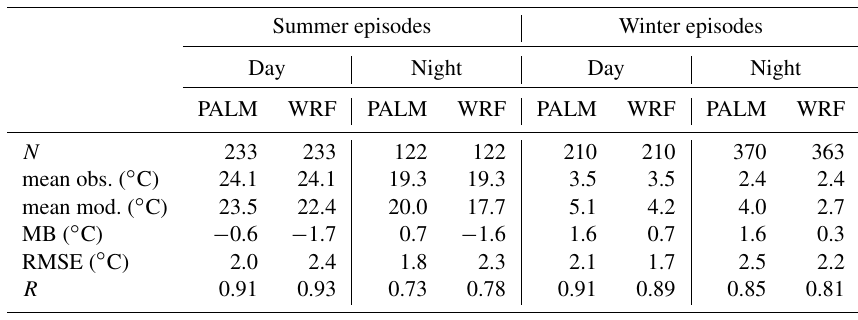
Table 3. Statistical metrics of modelled 1h averaged air temperature within different street canyons. The statistics are evaluated over all locations and episodes considered, and they are partitioned into summer and winter as well as day- and night-time. The statistical metrics for the modelled 2m air temperature in WRF are also given for completeness.